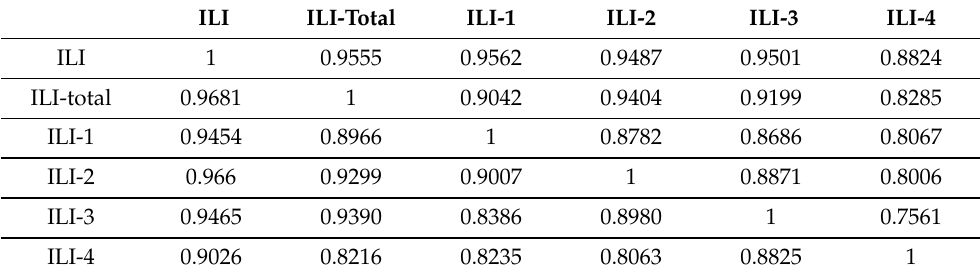
Table 6. Matrix [ µ 1 ] Max ,20,6